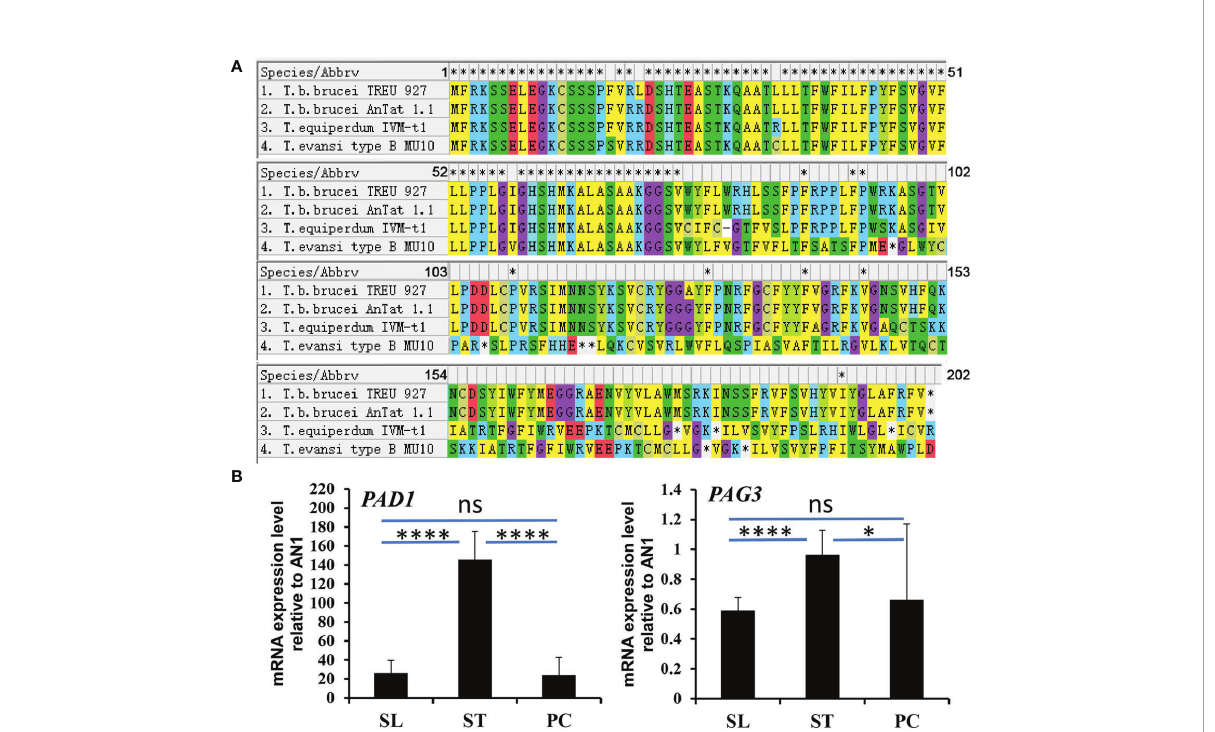
FIGURE 3 The alignment of PAG3 in T. brucei and its expression in different life stages of T. brucei. (A) The alignment of PAG3 in T. brucei with T. equiperdum IVM-t1 and T. evansi type B MU10. Possible frameshifts were found in T. equiperdum IVM-t1 and T. evansi type B MU10. (B) The expression of PAG3 in different life stages of T. brucei. The quantitative PCR analysis of RNA expression levels of PAD1 and PAG3 in different life stages of T. brucei. These values have been normalized to the transcripts of the Zinc fi nger protein (AN1). SL represents slender form; ST represents stumpy form; PF represents procyclic form. Error bars represent SD (n=3), 3 experiments. *P=0.0257, ****P<0.0001, ns, not signi fi cant (P=0.7461 in PAD1 and P=0.5576 in PAD1) using unpaired Student ’ s t test with Welch ’ s